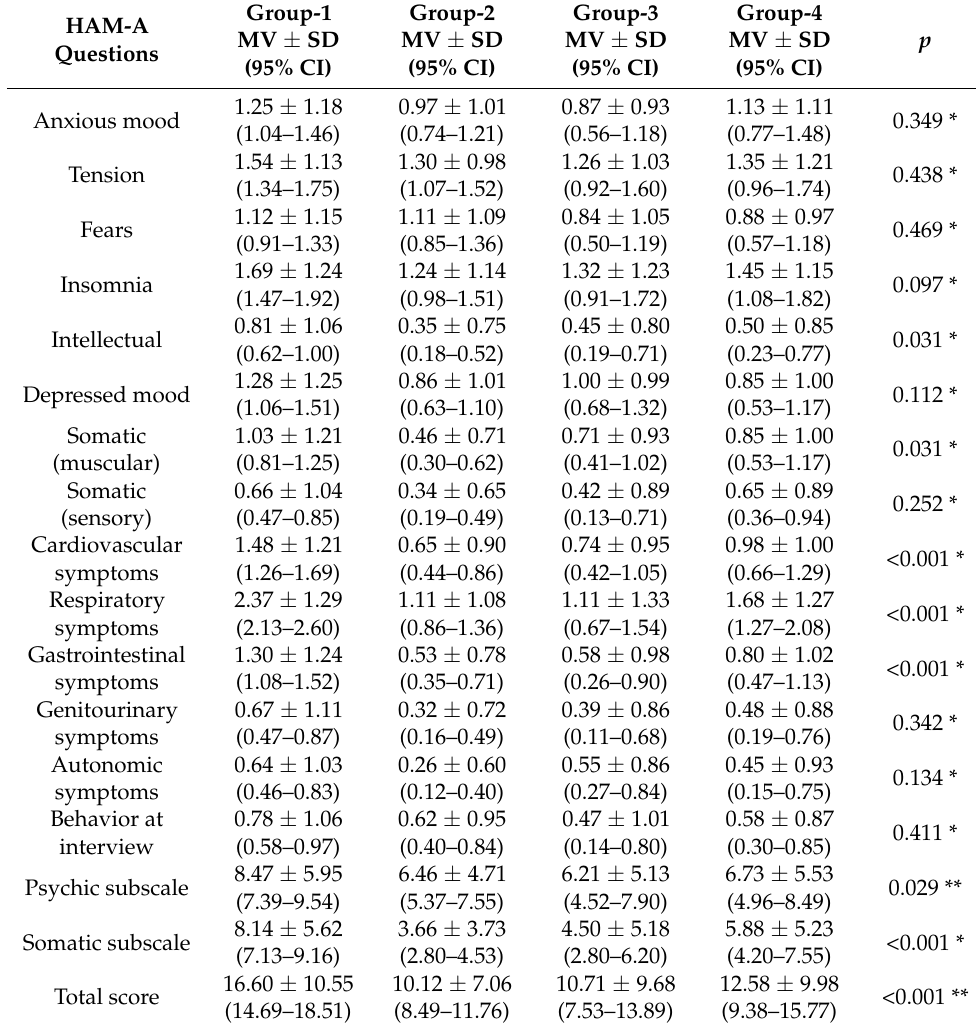
Table 2. Values of HAM-A questions in different pathologies and comparisons among them.